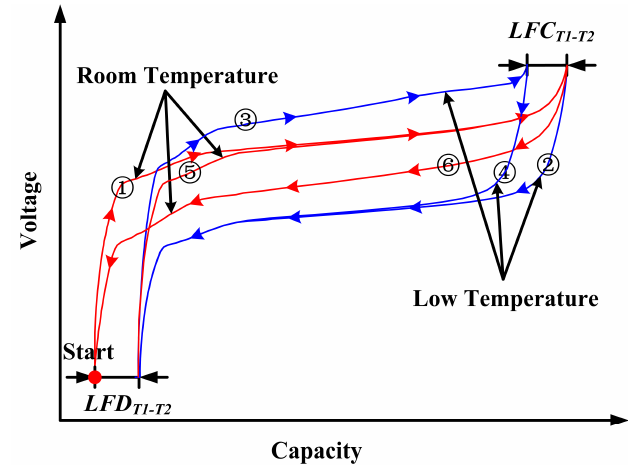
Figure 4. Test process of capacity loss at different temperatures.